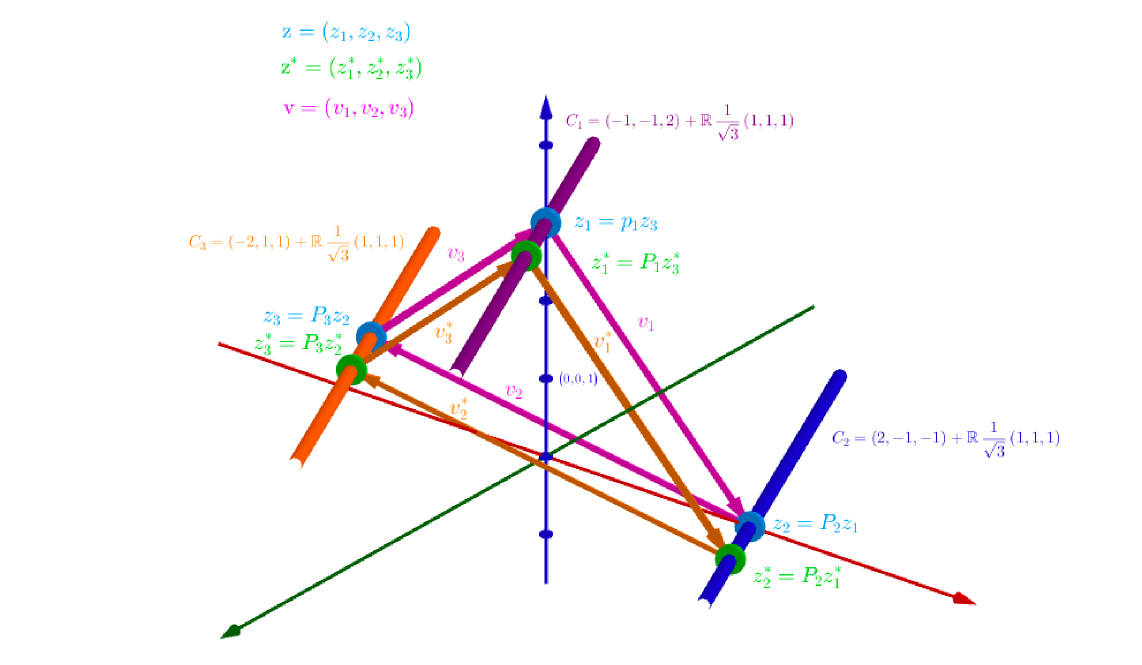
Figure 1 Visualization of the cycles and the difference vectors for three parallel lines in R 3 . See Section 5.1.1 for